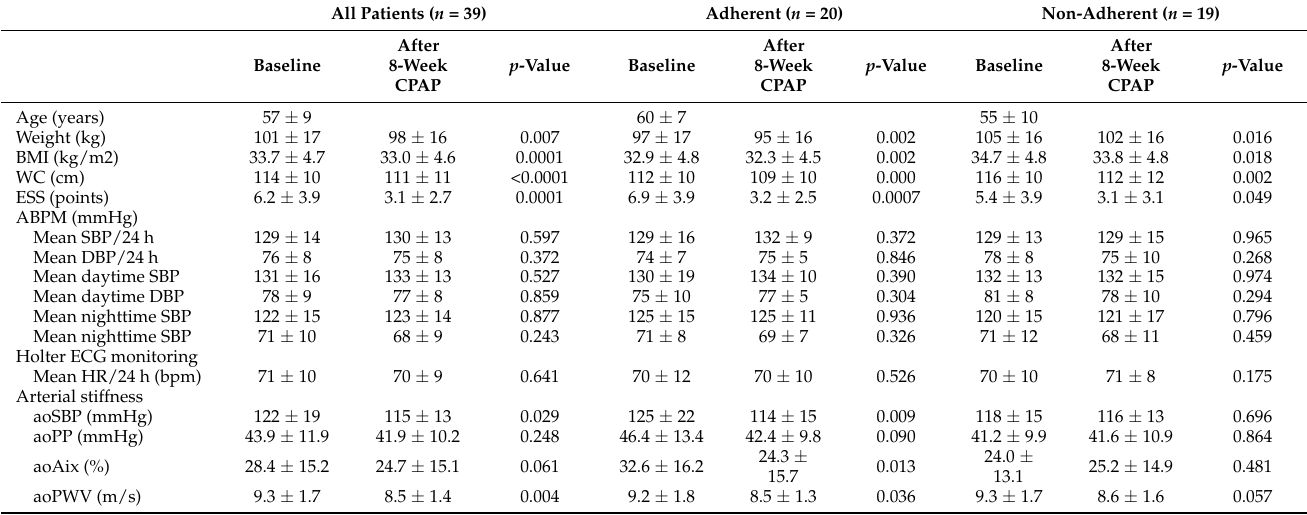
Table 2. Impact of 8-week CPAP therapy on arterial stiffness parameters in our study group. All Patients ( n =